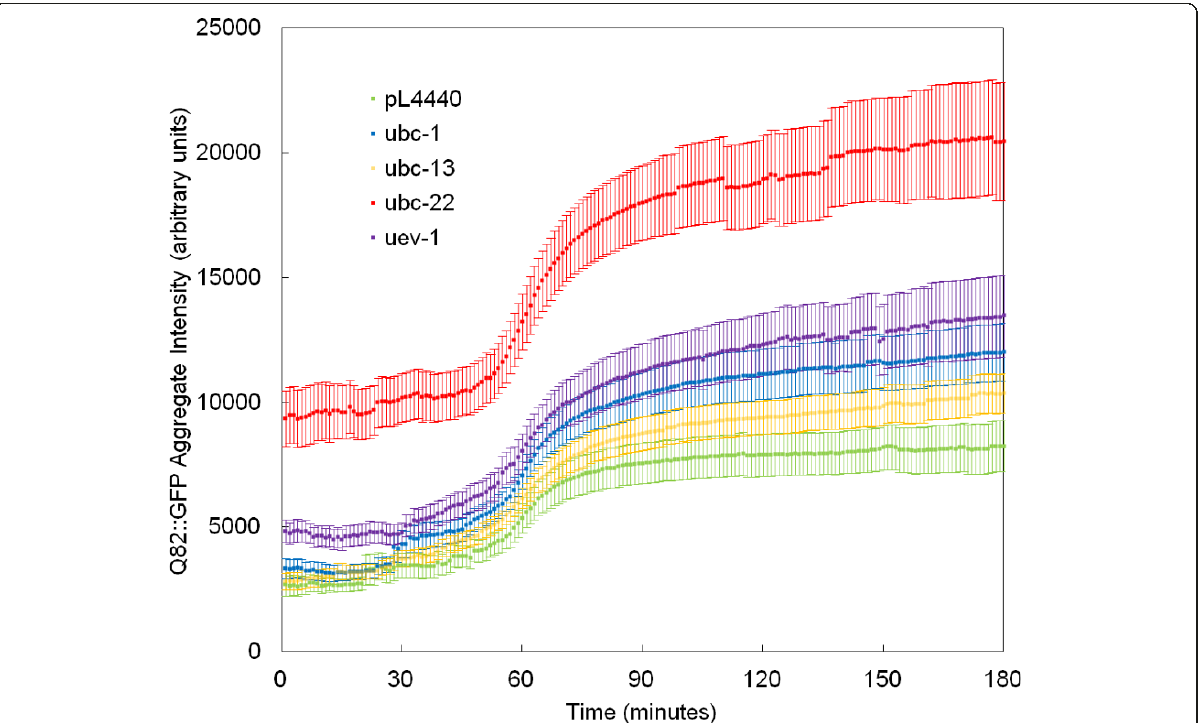
Figure 2 RNAi knockdown of UBCs affects the cellular level and aggregation rate of Q82::GFP fusion protein . C. elegans expressing a Q82:GFP transgene were fed bacterial clones expressing dsRNA against the indicated genes or the empty pL4440 vector as a control, beginning at the L2 stage. The progeny of these worms were imaged at a rate of 1 frame per minute. Pixel intensity in a square region of the image sequence in which an aggregate formed was measured over time. Plots of individual formation events were aligned along the time axis so that the frame at which the aggregation rate is highest occurs at 60 minutes. This chart shows the mean (± SEM) aggregate intensity at each time point for each RNAi treatment. At least 50 aggregates were analyzed for each RNAi treatment. See Table 1 for calculation of aggregation rates.